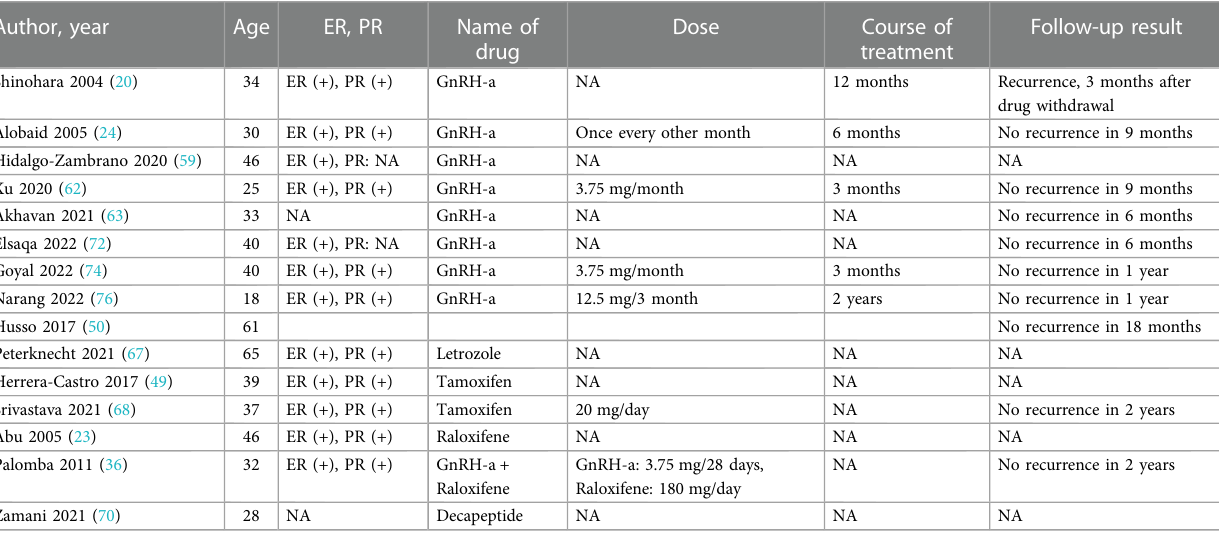
TABLE 5 Postoperative drug